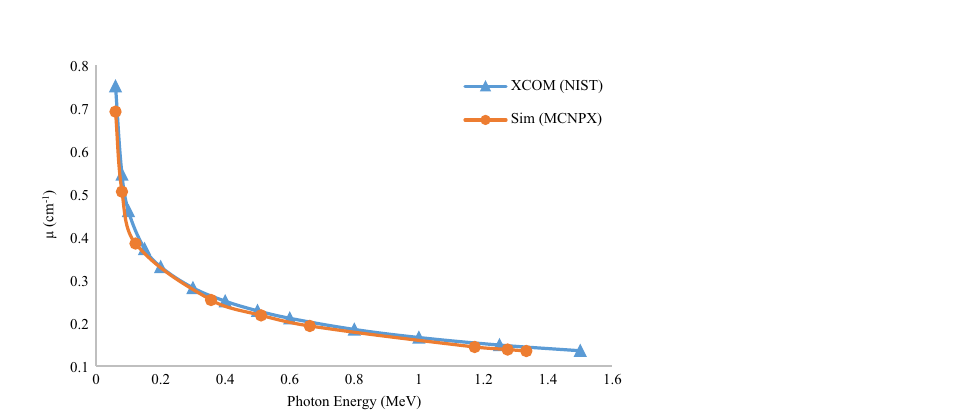
Figure 12. Comparison of attenuation coefficient of Aluminium extracted from XCOM and